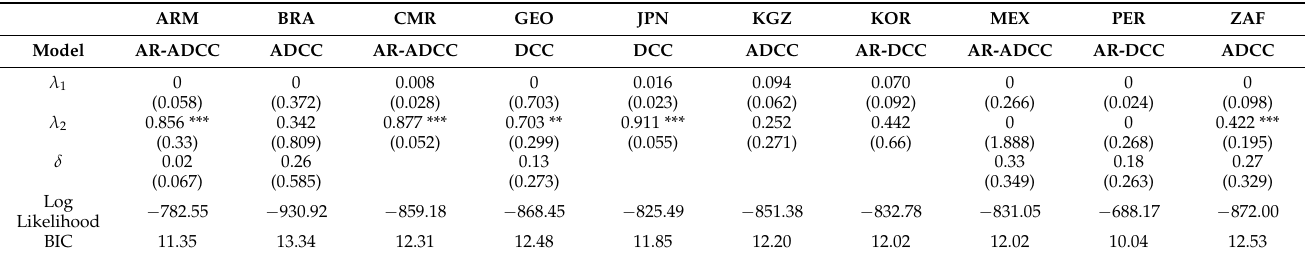
Table 6. Results of DCC-GARCH models.